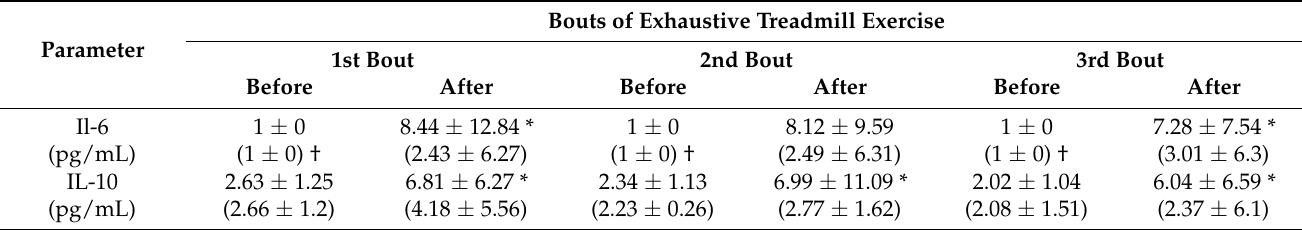
Table 3. Level of IL-6 and IL-10 before and after each of three bouts of exhaustive treadmill exercise.